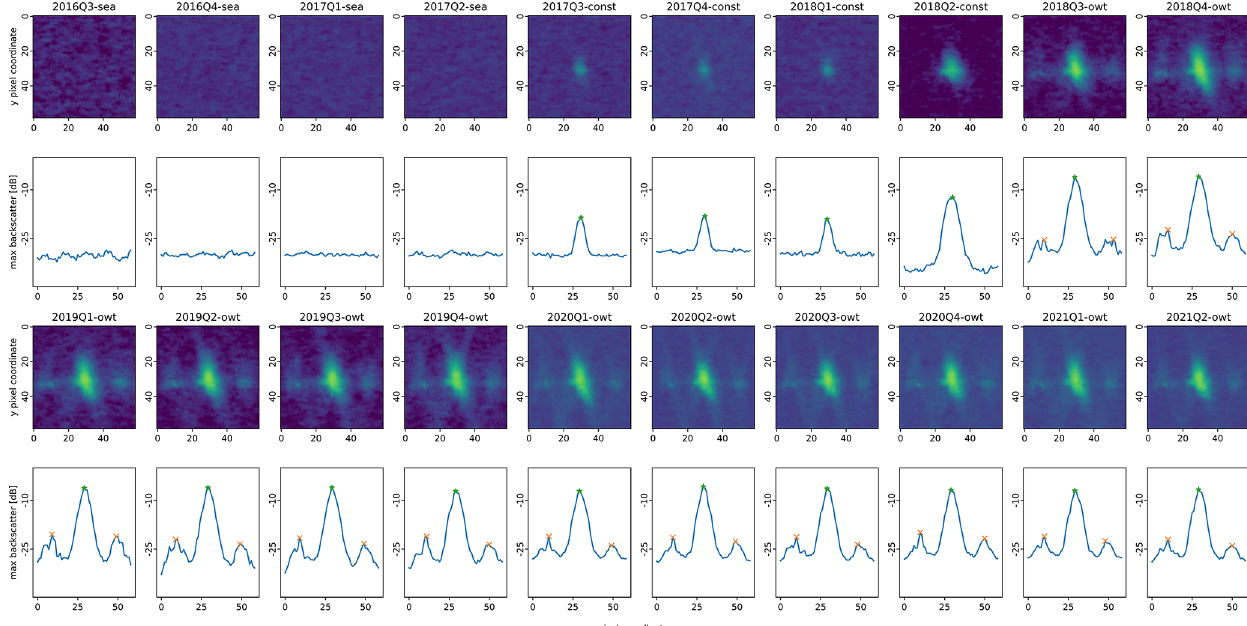
Figure 6. Deployment time series from 2016Q3 to 20201Q2 of an OWT. The first and third rows show quarterly Sentinel-1 median compos- ites of the same detected bounding box over time. The second and fourth rows show the corresponding maximal swath profiles with detected peaks. The automatically derived construction stages are given for each image. The abbreviations used in the figure are as follows: sea – open sea/no turbine, const – under construction, and owt – offshore wind